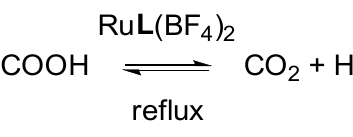
Figure 13. Formic acid decomposition by the Ru L (BF 4 ) 2 complexes.